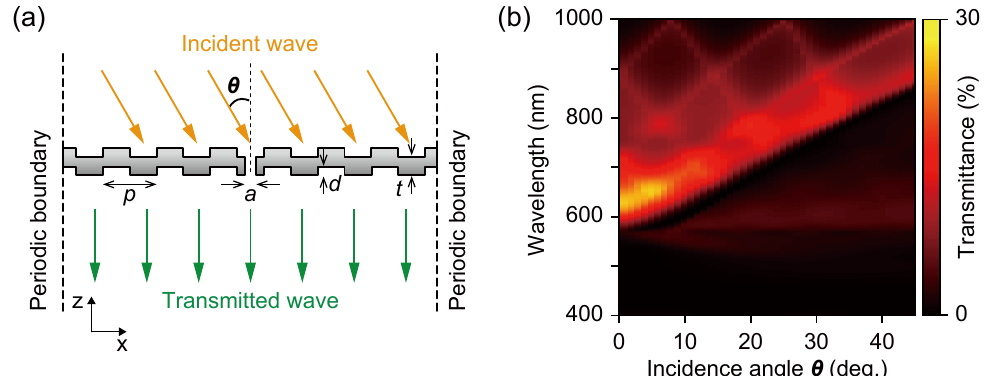
Figure 3. ( a ) The simulation model for the angle of incidence (AOI) dependence of the transmission spectrum. ( b ) The simulated transmittance spectra of AOI dependence for values of p = 500 nm, d = 80 nm, t = 180 nm, and a = 90